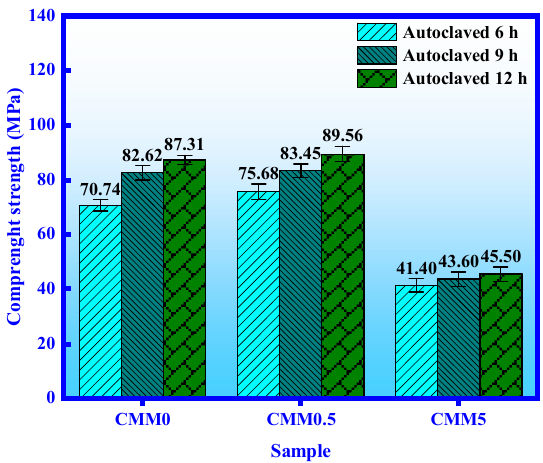
Figure 6. Compressive strength of CMM for autoclaved at 6, 9 and 12 h.